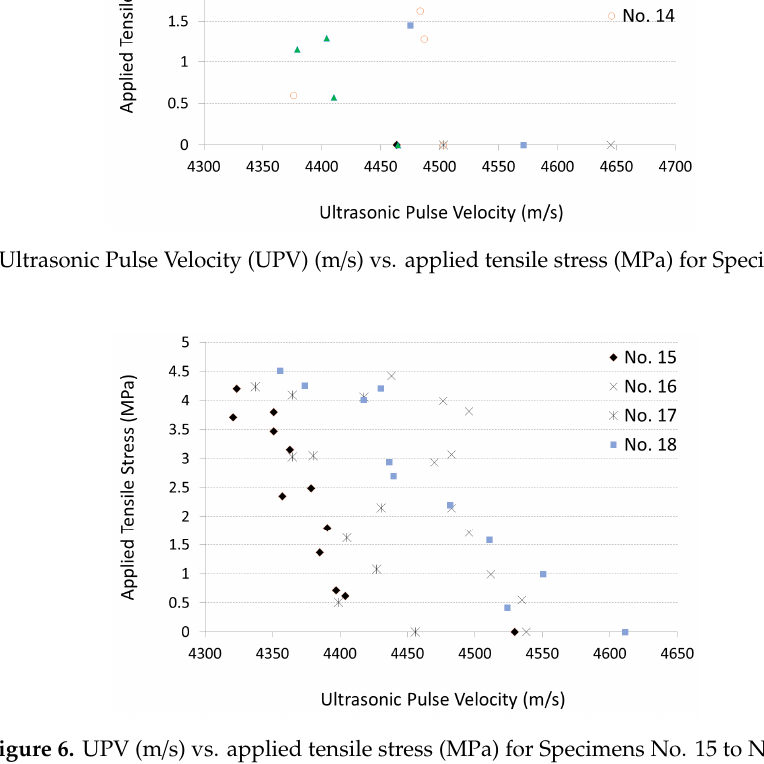
Figure 6. UPV (m/s) vs. applied tensile stress (MPa) for Specimens No. 15 to No. 18.